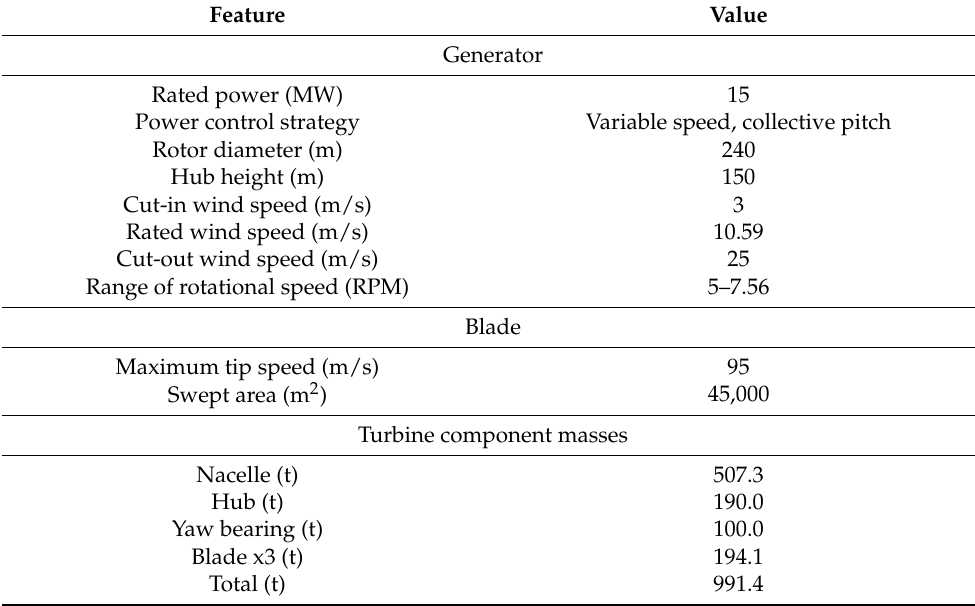
Table 14. IEA 15-MW turbine